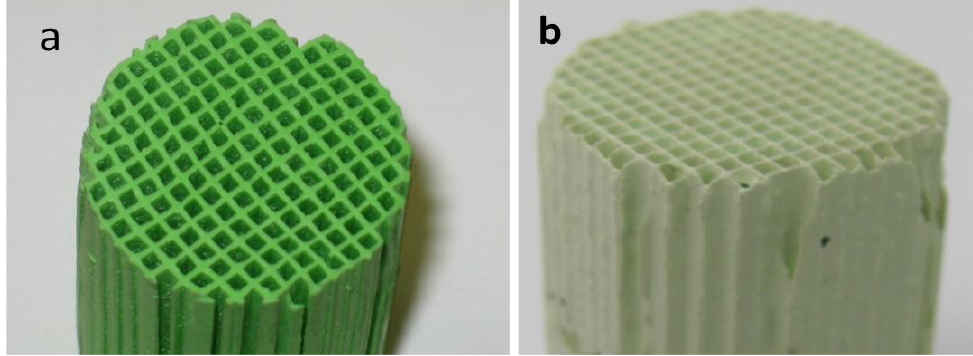
Figure 5. Pictures of ( a ) MNS extruded monolith and ( b ) MNS washcoated cordierite